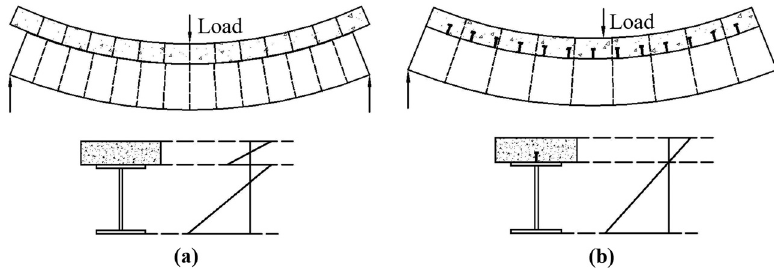
Figure 1: ( a ) Non - composite and ( b ) composite beam [ 7 ]